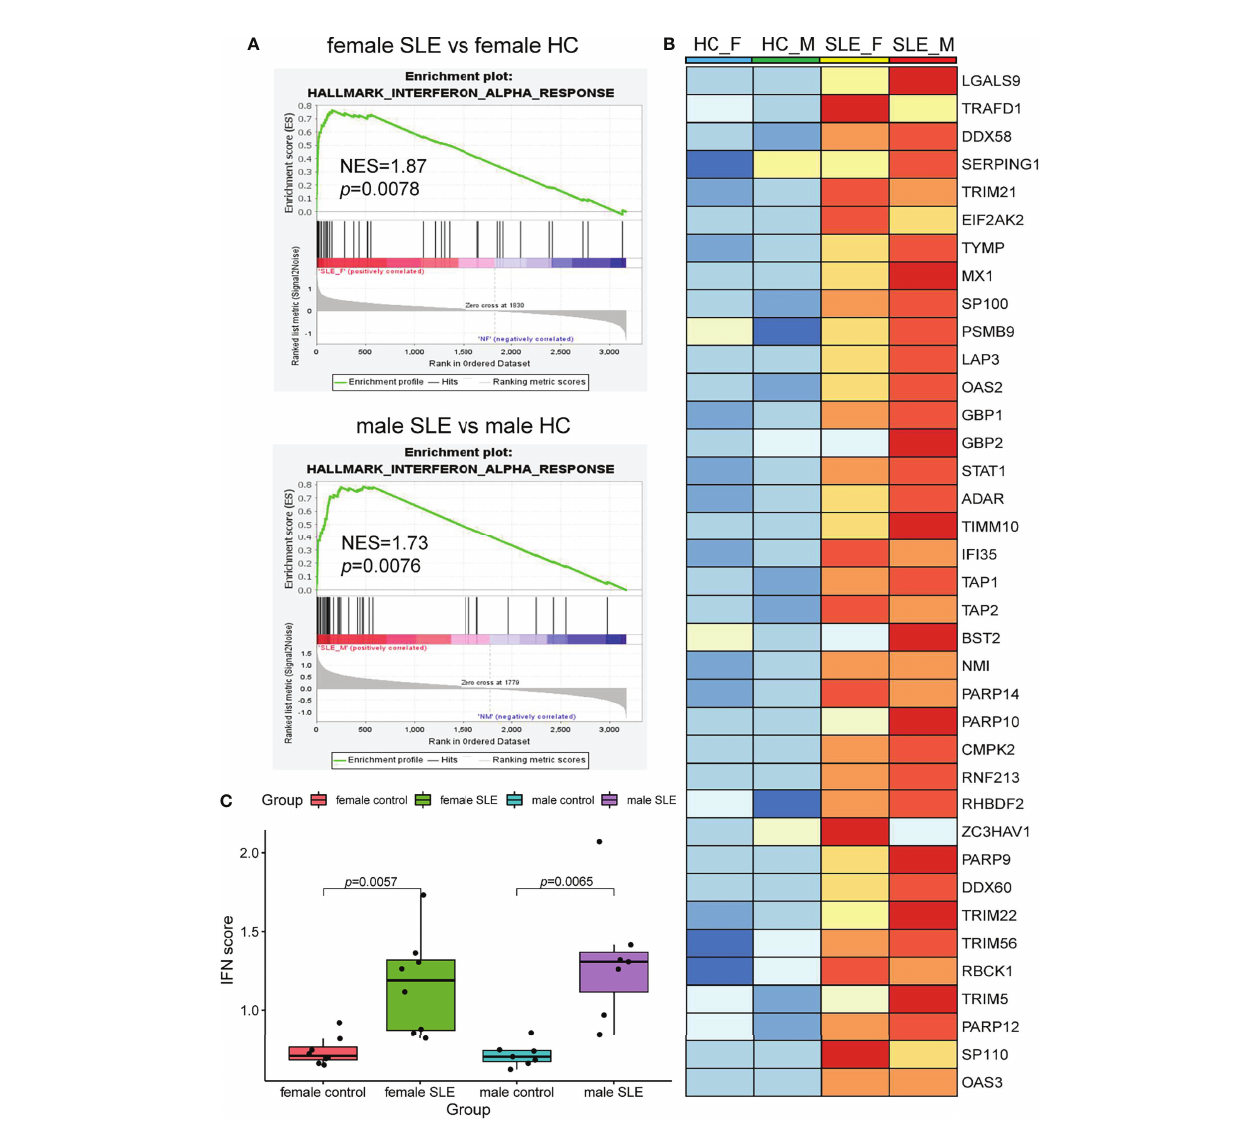
FIGURE 4 | Interferon signaling activation is a common feature in male SLE and female SLE. (A) Hallmarks gene set enrichment analysis (GSEA) showing pathways enriched in SLE compared to healthy control with different gender. NES: normalized enrichment score, p: p-value of enrichment analysis. (B) Boxplot showing type I interferon score among SLE and healthy control with different gender. (C) Heatmap showing the expression of core proteins that contribute to type I interferon pathway enrichment (red, high abundance; blue, low